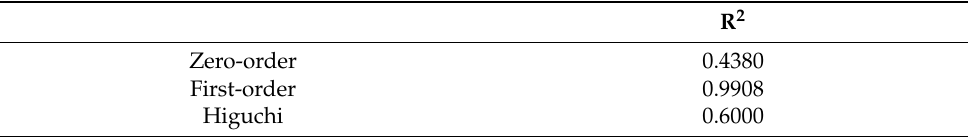
Table A2. Correlation factors of the fitted mathematical